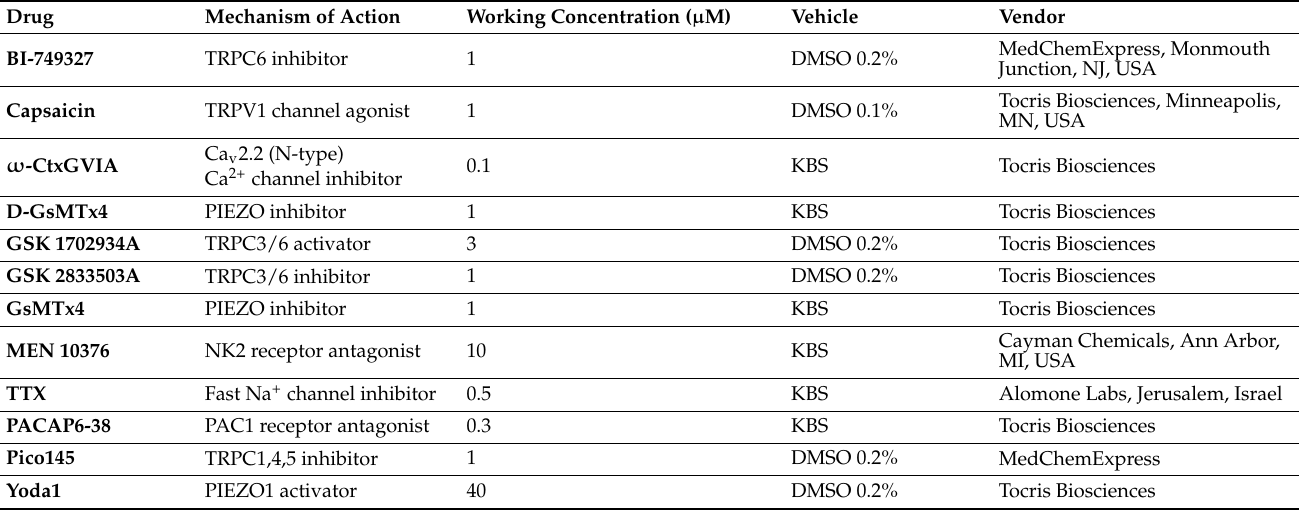
Table 1. Activators and inhibitors of membrane receptors and channels used in this